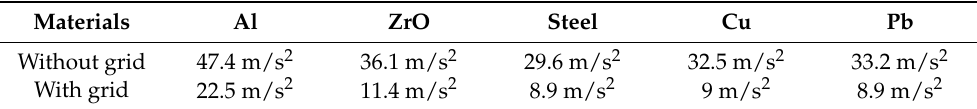
Figure 8. Vibration response of cantilever beam with and without obstacle grid particle dampers with different particle materials. Table 4. Vibration acceleration response under different particle materials.